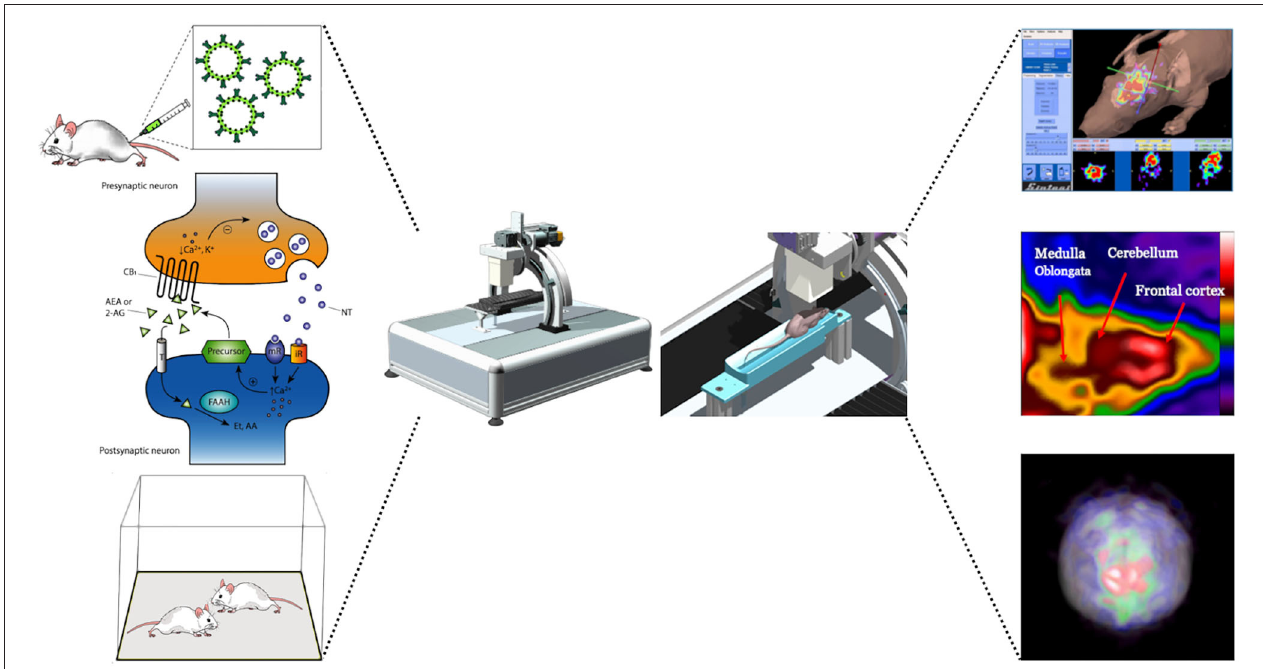
FIGURE 5 | Schematic illustration of a potential experiment to map neuronal activity by using a SPECT system. After the radiotracer is injected via the tail vein, the experimental subject undergoes behavioral testing and the neuronal response can be obtained from changes in receptor occupancy levels using SPECT imaging. Images shows changes in receptors signal following the behavioral